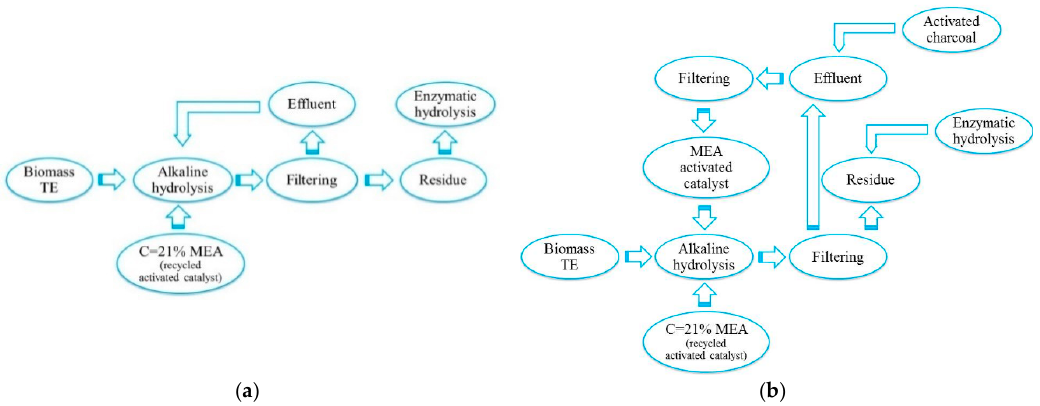
Figure 1. Schematic diagram of MEA catalyst re-use ( a ). direct approach ( b ). purifying approach.